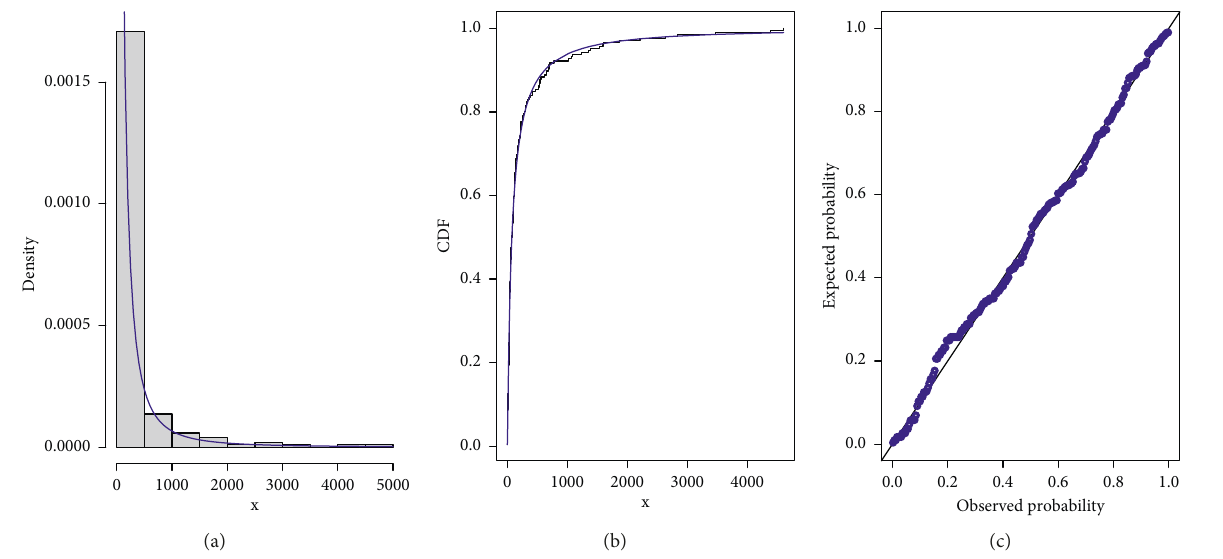
Figure 6: Histogram, CDF, and PP plots of EFL distribution for catastrophe data. Table 8: Descriptive statistics of collision data.